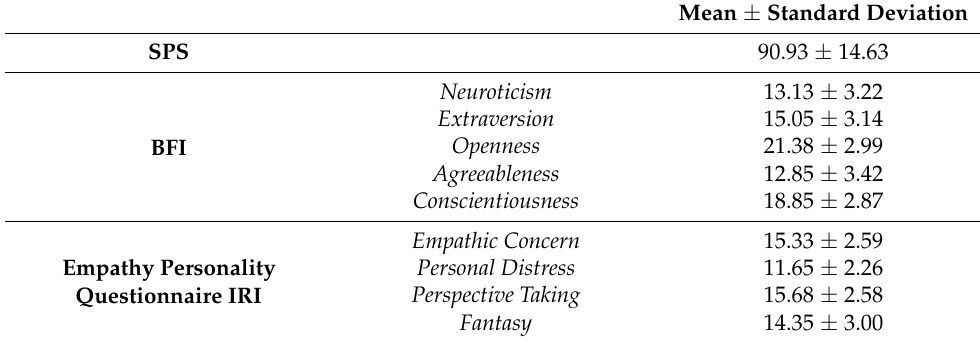
Table 1. Results of personality questionnaires SPS, IRI, and BFI.